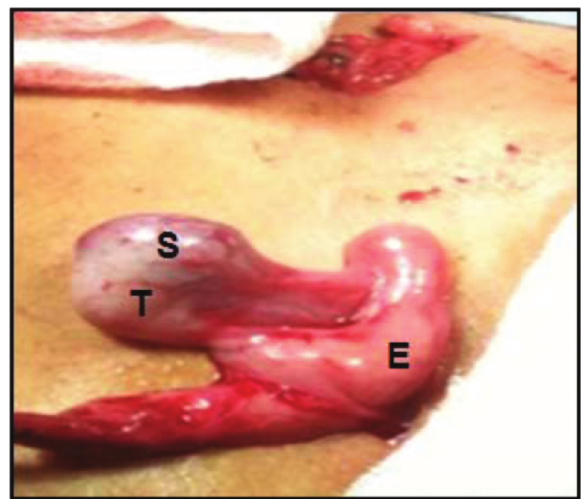
Fig. 1 Figure shows the left testicle. S, Splenic tissue; T, testis; E,